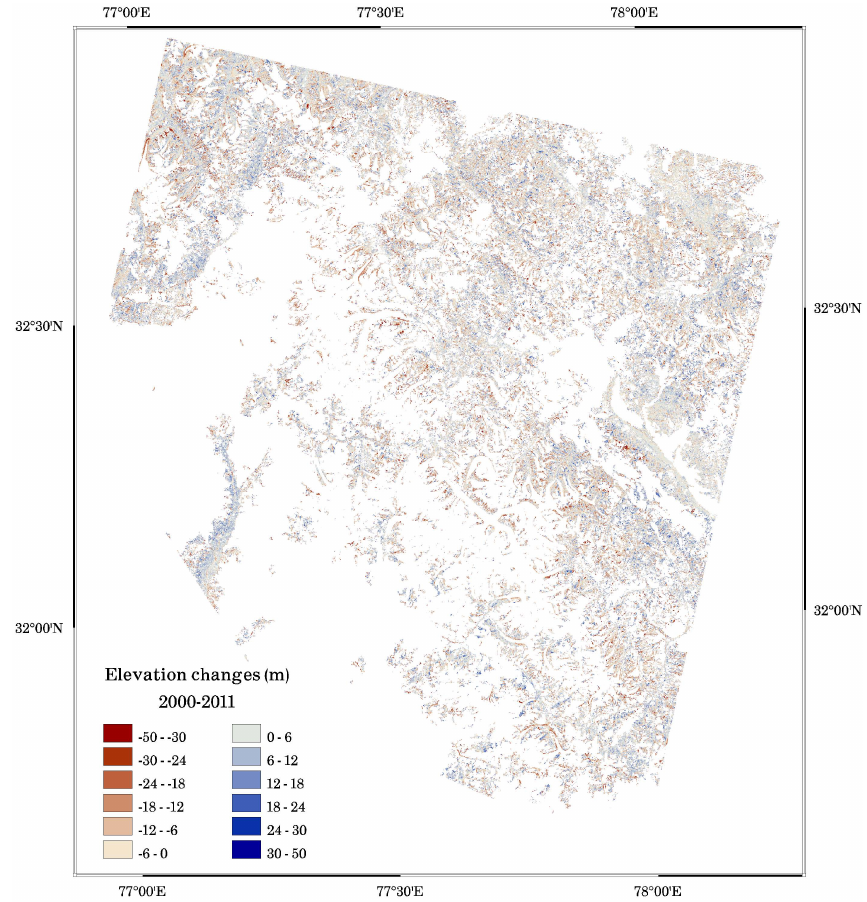
Fig. A1. Map of elevation changes between February 2000 and October 2011 off glaciers in the Lahaul and Spiti